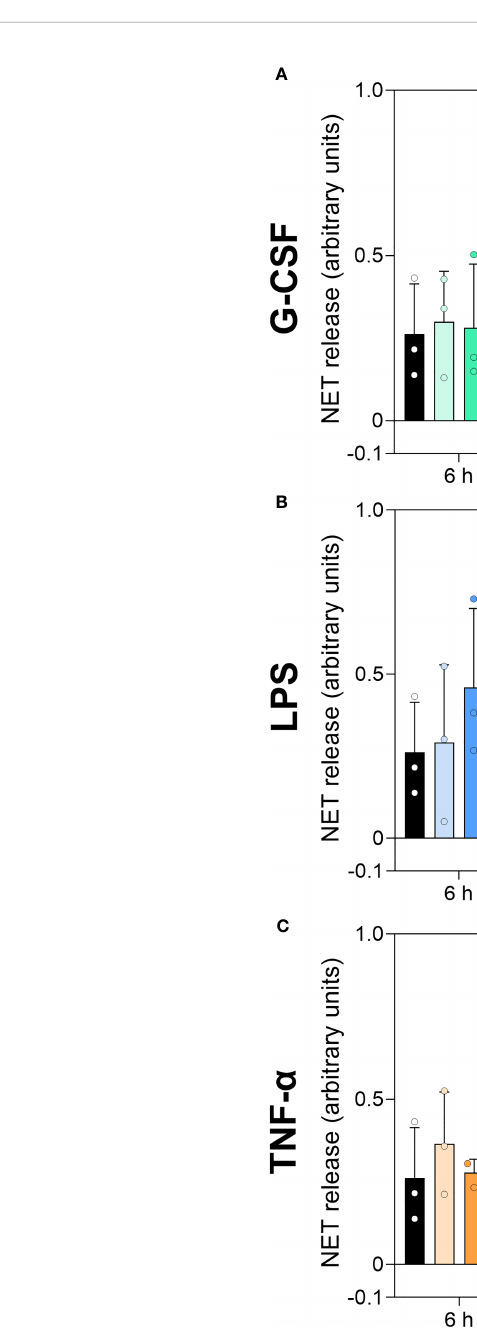
FIGURE 7 | DNA-MPO complexes after stimulation with PMA in neutrophils incubated with G-CSF, LPS or TNF- a . Neutrophils were treated with G-CSF (A) , LPS (B) , TNF- a (C) or medium only for 6 h, 24 h, 48 h and 72 h. Extracellular MPO-DNA complexes were detected by sandwich ELISA: capture antibody was MPO- directed and detection of DNA by antibody for double-stranded DNA coupled with a peroxidase. Results were measured by fl uorometry at 650 nm. Values represent means ± SD of n = 3. Differences between the untreated control group and one treated group each were calculated individually using student ’ s t-test. Levels of signi fi cance were set at < 0.05 (*), < 0.01 (**), < 0.001